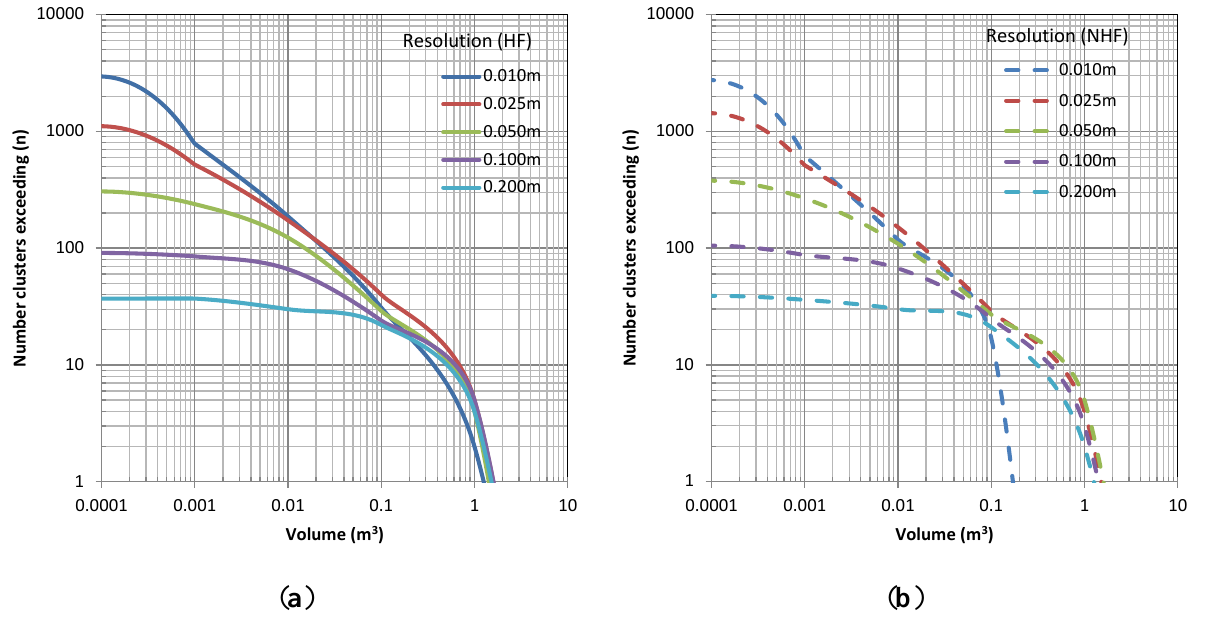
Figure 10. Comparison of magnitude–frequency curves (plotted based on exceedance) for various resolutions and with hole filling ( a , HF) and without hole filling ( b , NHF) for Site A between 2013 and